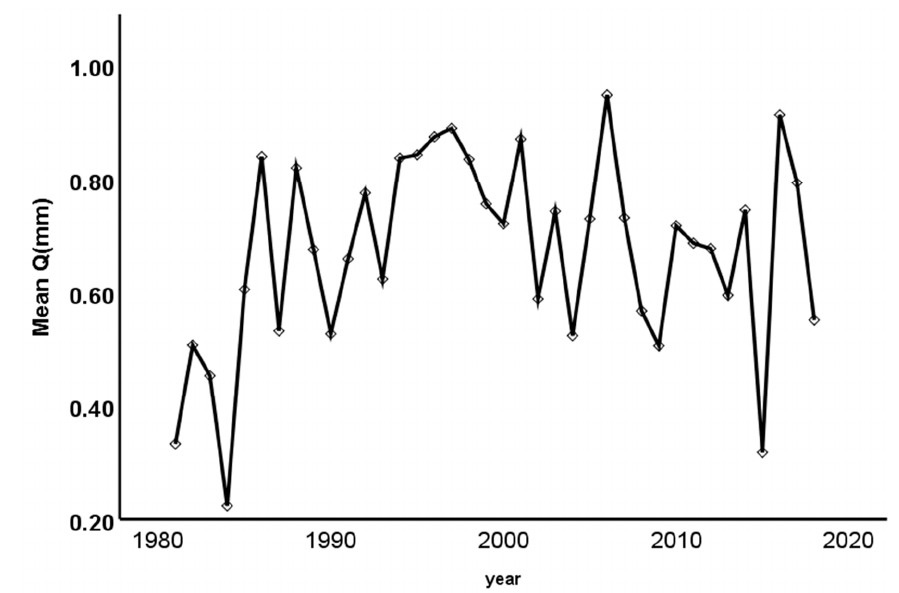
Figure 7. Estimated mean of the top ten significant discharge (Q, in mm) of years from 1981 up to2018.